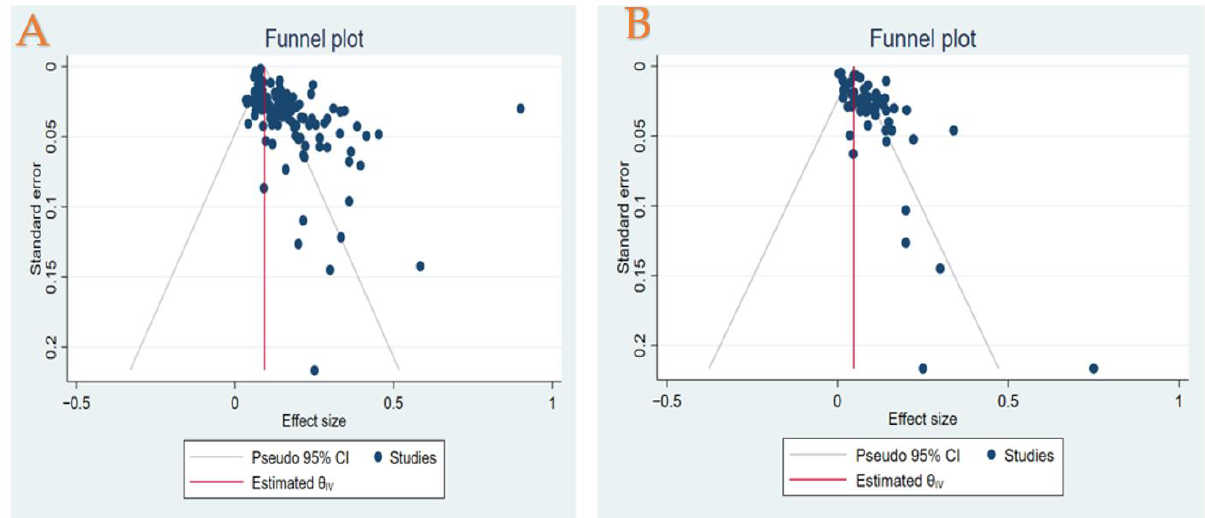
Figure 4. ( A ) Funnel plot of prevalence off recurrence rate in patients with HCC who underwent LT treatment. ( B ) Funnel plot of prevalence of mortality due to recurrence in patients with HCC who underwent LT treatment.